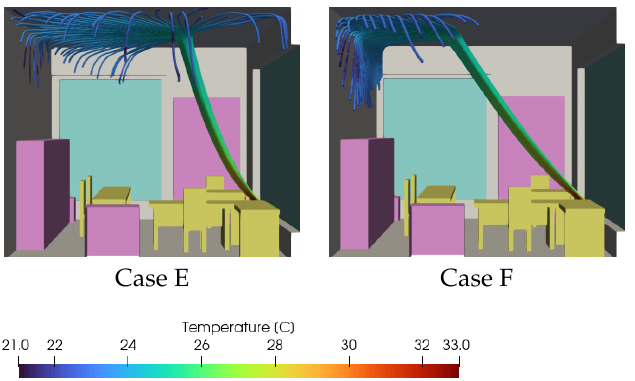
Figure 7. View form the entrance of the streamlines obtained for winter heating with low input air velocity (Case E) and high input air velocity (Case